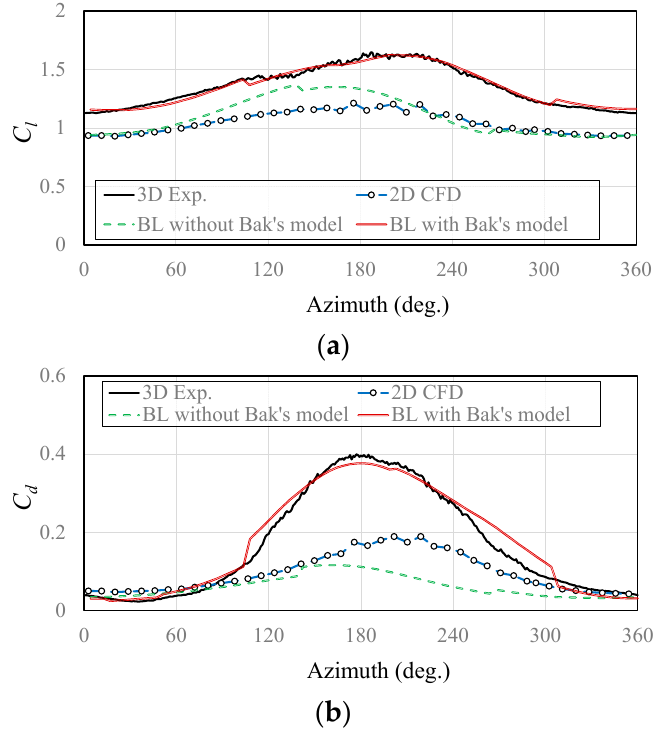
Figure 15. Validation of the corrected Beddoes-Leishman (B-L) dynamic stall model in lift coefficient and drag coefficient. The wind speed is 10 m/s, the yaw angle is 10°, and radial location is 30% span. ( a ) The lift coefficient; ( b ) The drag coefficient.